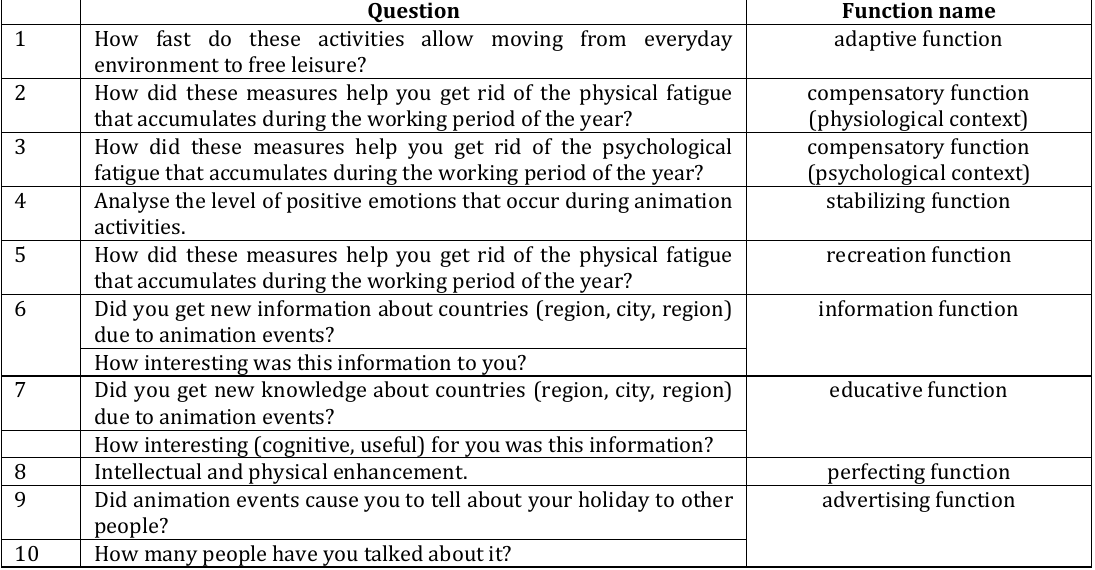
Table 1. Factors influencing the effectiveness of animation activities in hotel and restaurant facilities